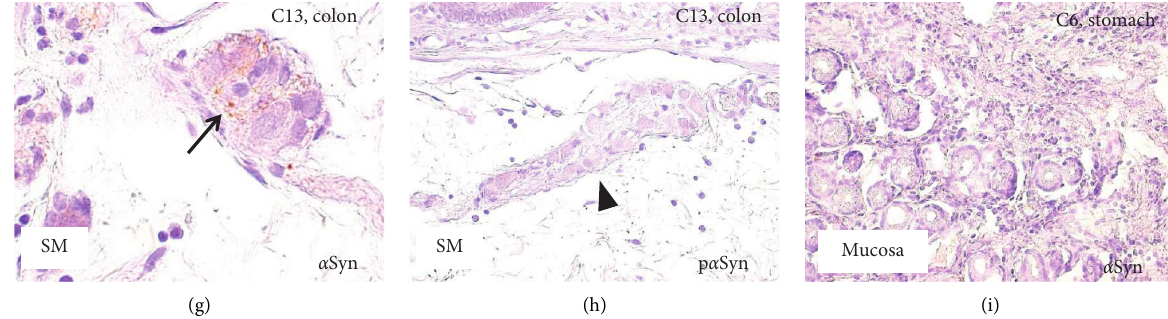
Figure 1: Immunohistochemical analyses of control patients. Immunohistochemistry for α -synuclein ( α Syn) (a, d, g, i), phosphorylated α -synuclein (p α Syn) (b, e, h), and PGP9.5 (c, f). (a–c) Sections of the stomach of patient C1; (d–f) sections of the colon of patient C3; (g, h) sections of the colon of patient C13; (i) sections of the stomach of patient C6. (a–f) Serial sections. Black circles indicate the myenteric plexus (a–c) and submucosal plexus (d–f). MP, muscularis propria; SM, submucosa. Accumulations of α Syn are observed in gastric myenteric plexus (a), intramuscular nerve fibers (small arrows in (d)), and colonic submucosal plexus (arrow in (g)), but not observed in the mucosa (i). Depositions of p α Syn are visible neither in the gastric myenteric plexus (b) nor in the colonic submucosal plexus ((e) and arrowhead in (h)). Components of the enteric nervous systems are visualized with PGP9.5 (c, f). Scale bar: 50 μ m (a–c, h, i), 100 μ m (d–f), and 20 μ m